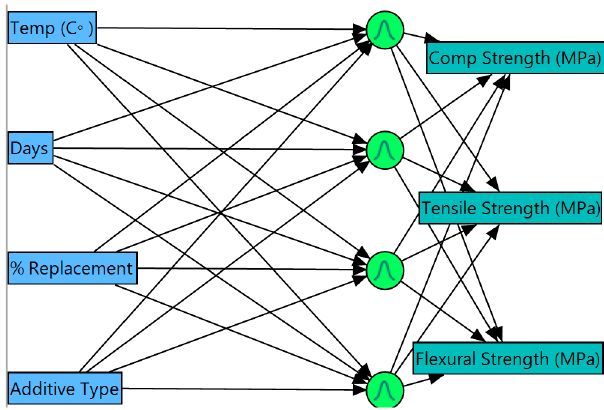
Figure 6. Artificial Neural Networks (ANNs) structure for self-compacted concrete.